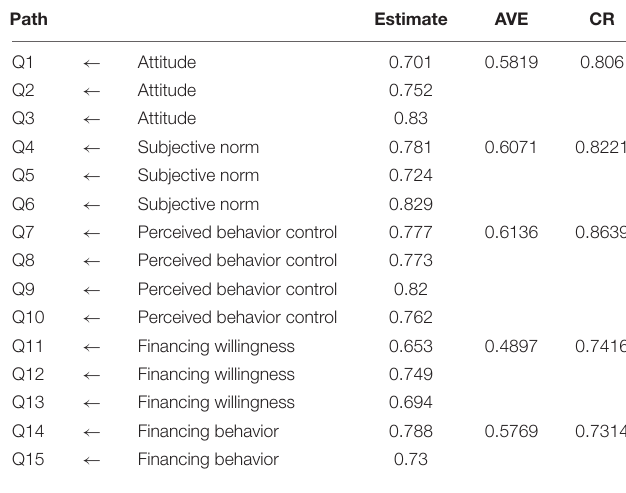
TABLE 9 | Standardized regression coefficients and standard errors for latent variable